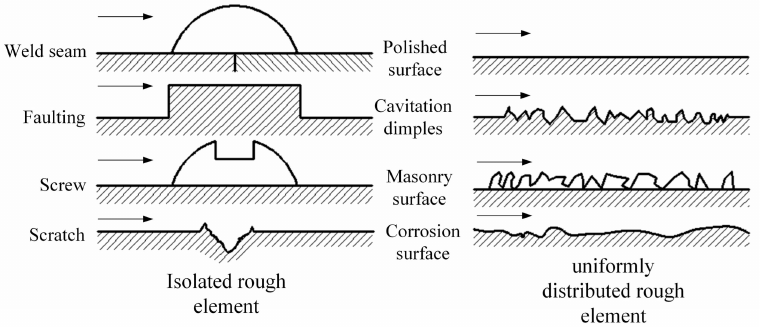
Figure 1. Irregular surface of flow field boundary (The arrow points in the direction of fluid